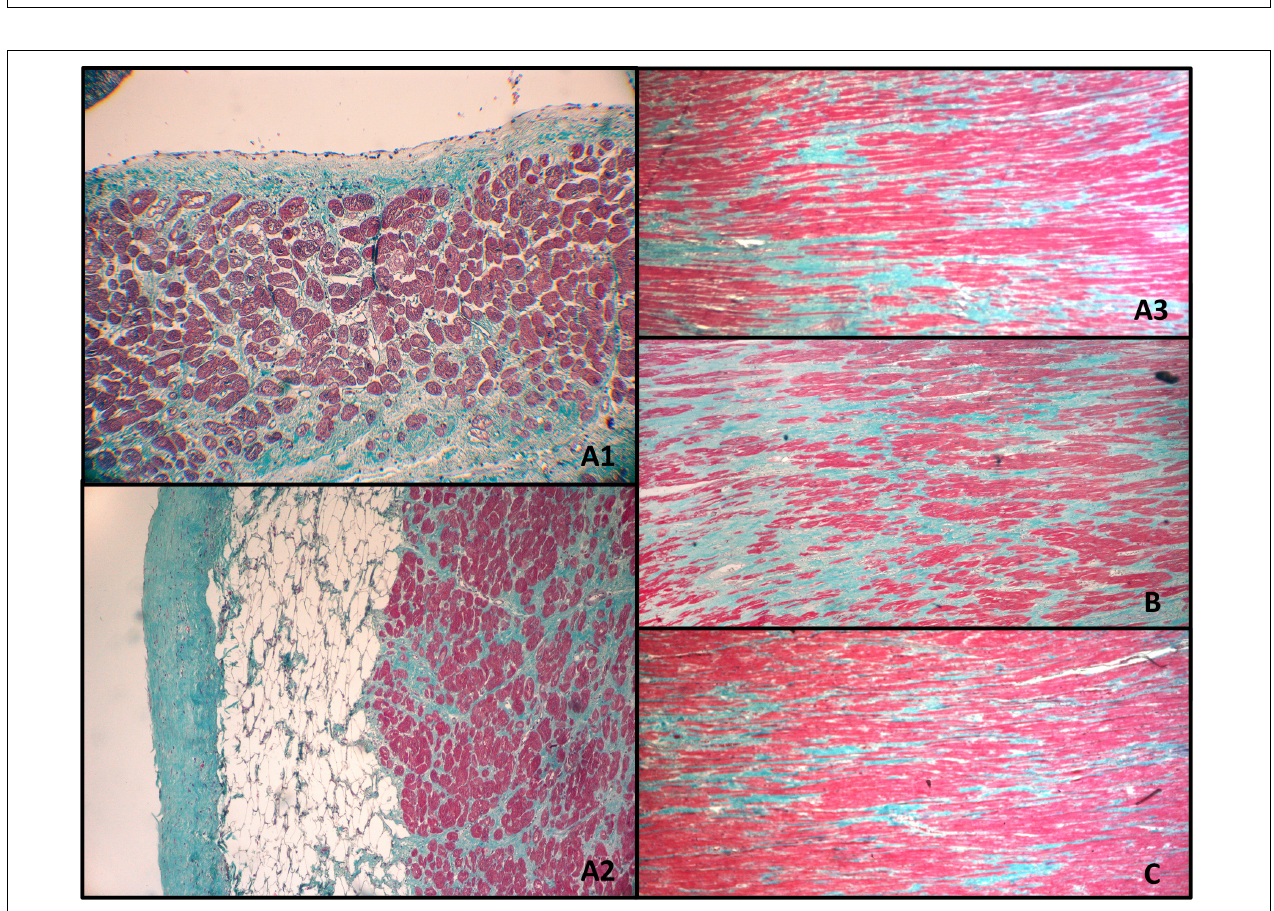
FIGURE 5 | Cardiac-CT images adjusted to the slices performed during the autopsy of the explanted heart. Blue outline (1-2) marks the region irradiated with approximately 7.5 Gy, while violet outline (2-3) shows the planning target volume to which 25 Gy was prescribed. The arrows and letters indicate the approximate localization of the pathology specimens referenced in the article.